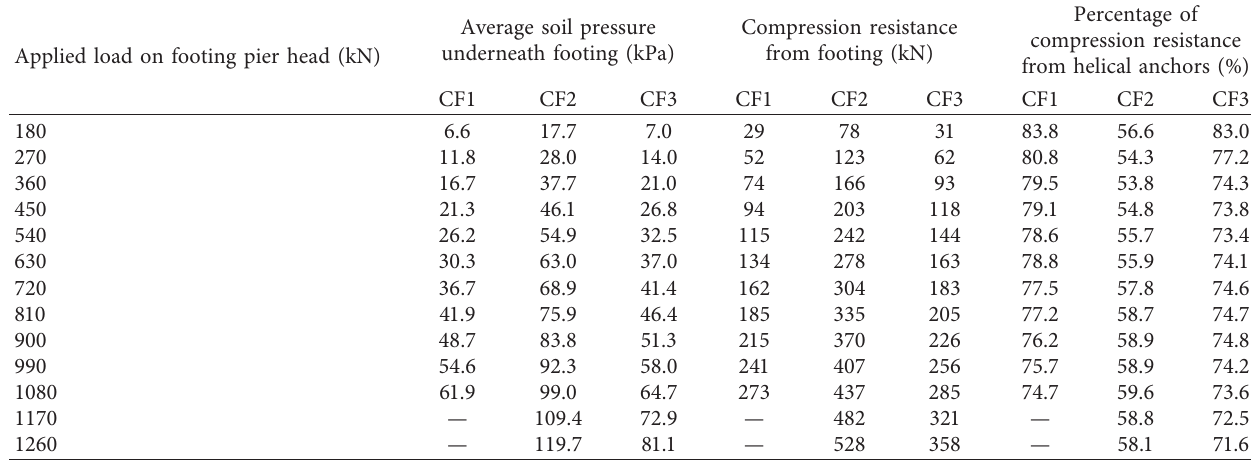
Table 4: Average soil pressures and compression resistances from footing and helical anchors. Applied load on footing pier head